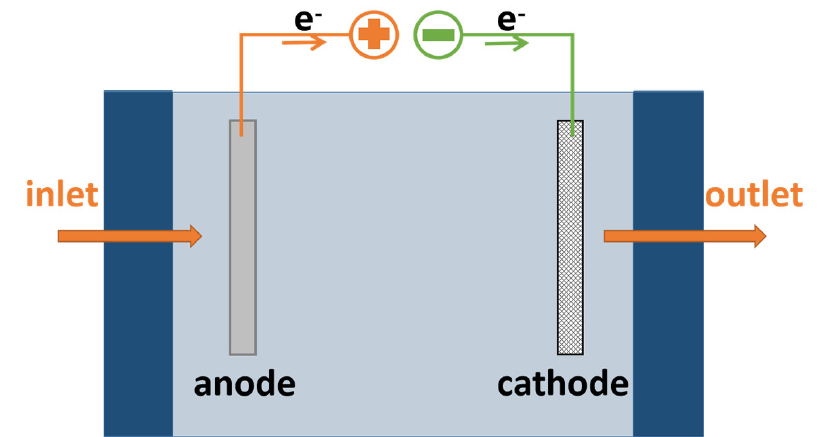
Figure 3. Schematic diagram of traditional plate-frame ECRs.